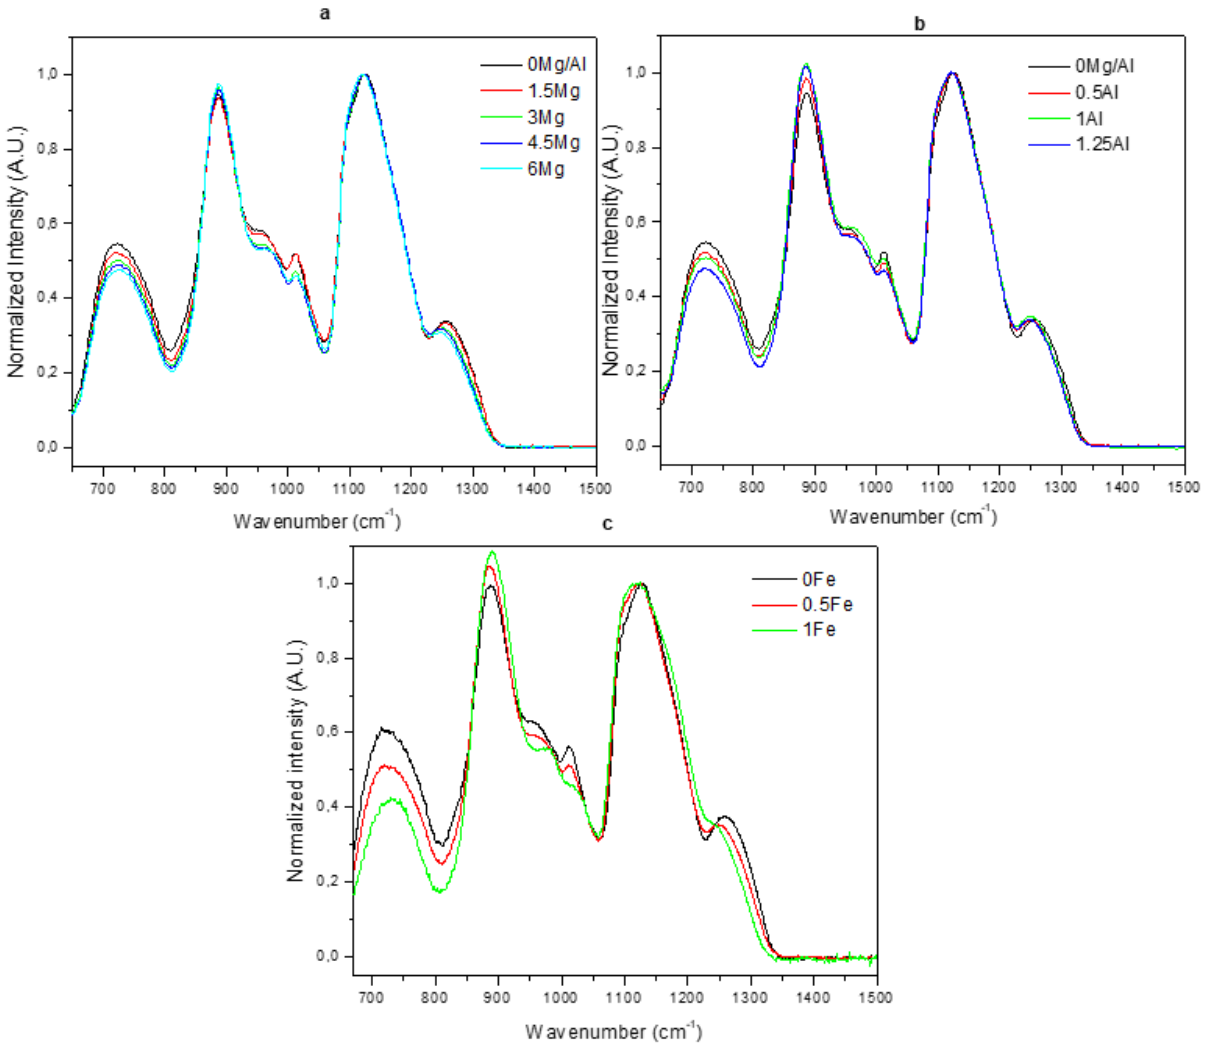
Figure 1. Normalized IR spectra of the investigated Mg ( a ) Al ( b ) and Fe ( c ) glasses. The spectra are normalized to the maximum band at 1100 cm −1 .